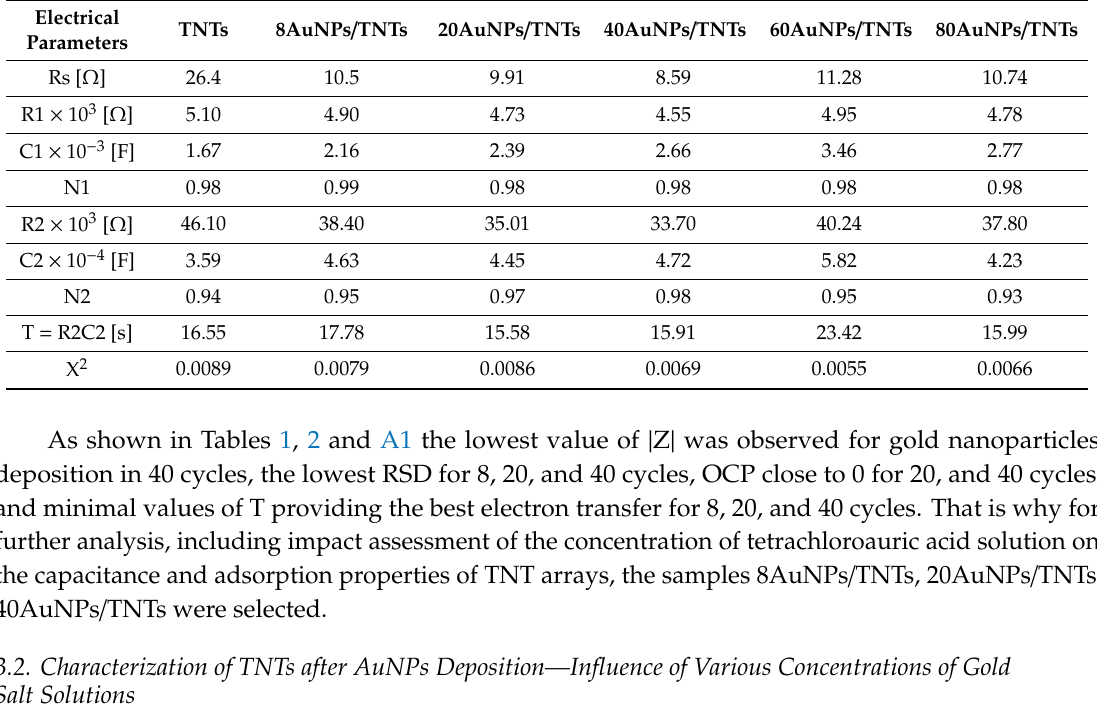
Table 2. Value of circuit equivalent elements for TNTs and AuNPs / TNT